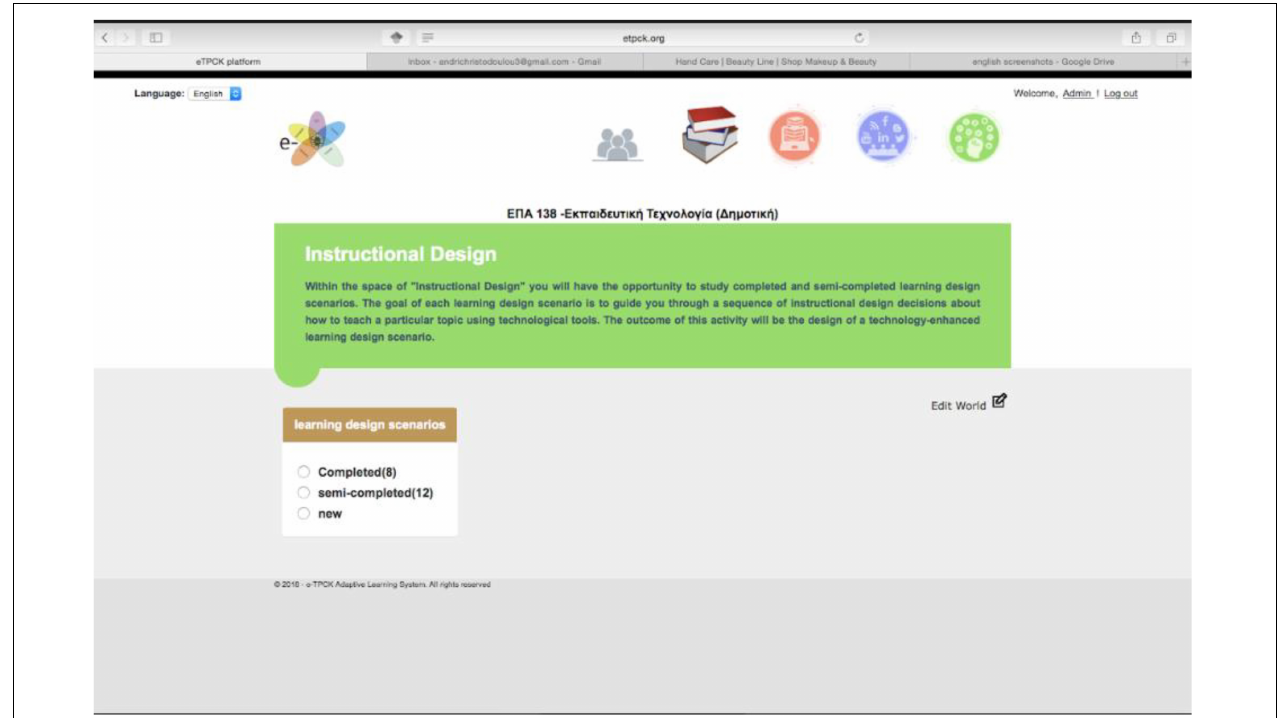
FIGURE 3 | Instructional design